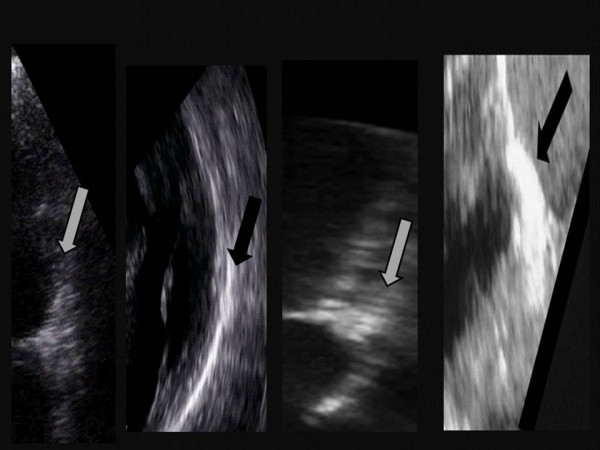
From left to right, examples of normal mitral annulus and calcified mitral annulus (mild = 1–2 mm, moderate = 2–5 mm and severe >5 mm calcified annulus).